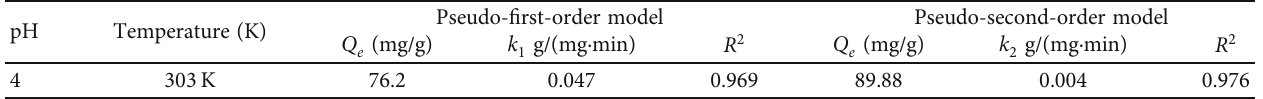
Figure 13: Graph of adsorption capacity over time and fi tting curve of the pseudo- fi rst-order model and pseudo-second-order model. Table 5: Kinetic fi t data